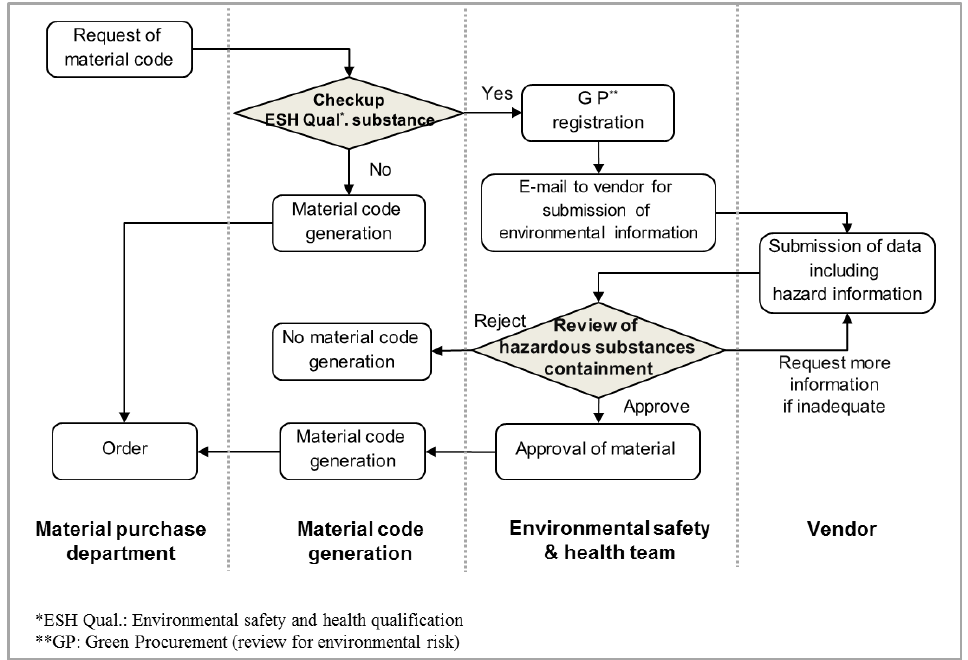
Figure 1. Environmental safety and health quality process for the prevention of hazardous material Figure purchase.